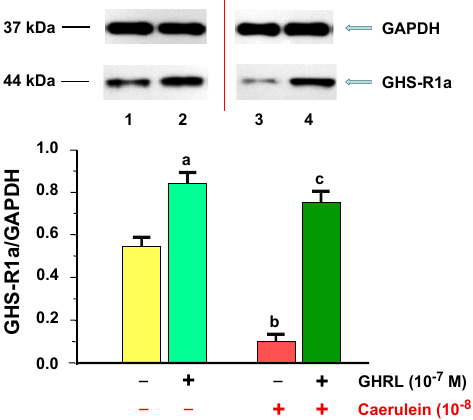
Figure 6. Analysis of the growth hormone secretagogue receptor 1a (GHS-R1a) protein production determined by the methods of immunoblotting and immunoprecipitation, and densitometric analysis of GHS-R1A/glyceraldehyde-3-phosphate dehydrogenase (GAPDH) protein ratio in AR42J cells: (line 1) control cells incubated in caerulein-and GHRL-free solution; (line 2) cells incubated in caerulein-free solution containing GHRL at a concentration of 10 − 7 M; (line 3) cells incubated in solution containing caerulein at a concentration of 10 − 8 M without addition of GHRL; (line 4) cells incubated in solution containing caerulein at a concentration of 10 − 8 M and GHRL at a concentration of 10 − 7 M. Reference protein: GAPDH. a,b p < 0.05 compared to control cells incubated in caerulein-and GHRL-free solution (line 1); c p < 0.05 compared cells incubated in solution containing caerulein without addition of GHRL (line 3). In each experimental group, the number of observations was at least 6.